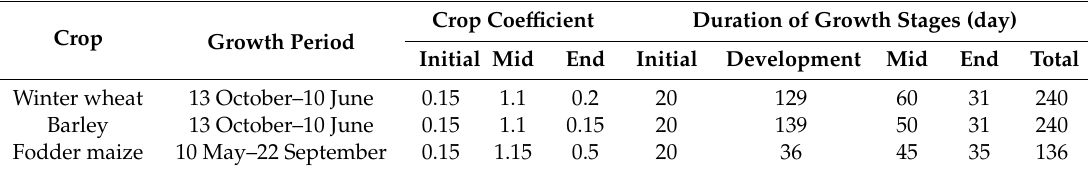
Table 3. Crop coe ffi cients, growth period, and duration of growth stages for winter wheat, barley, and fodder maize in the Qazvin Plateau.